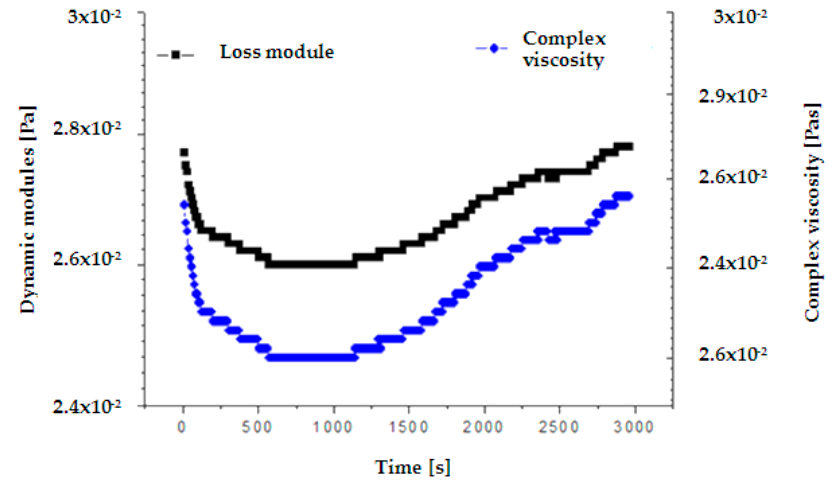
Figure 14. Loss module and complex viscosity for EM_2c after 24 h from manufacturing.